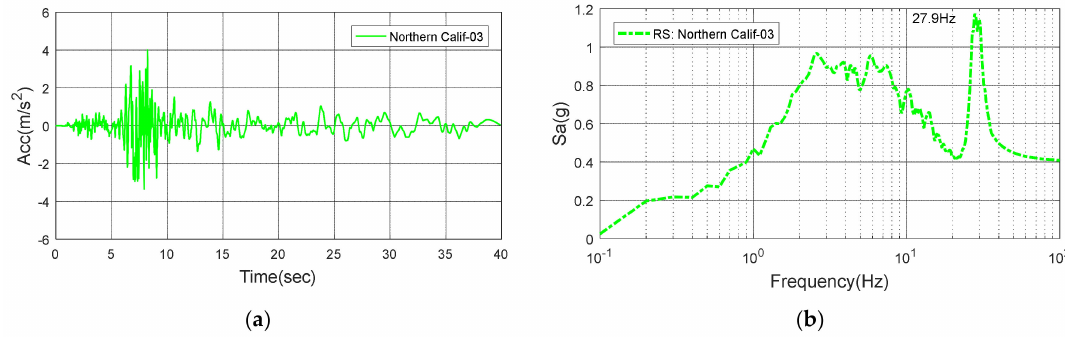
Figure 15. Northern Calif-03: ( a ) Time history; ( b ) Response spectrum.